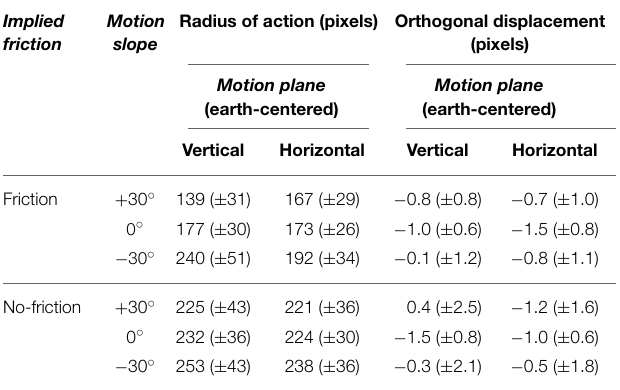
TABLE 1 | Descriptive statistics of behavioral data.